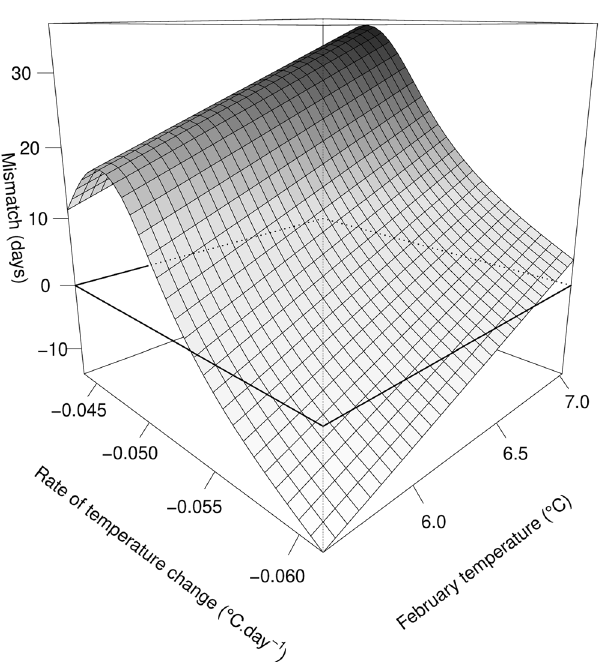
Figure 4. Relationship between the mismatch measure, the rate of temperature decrease (September- February) and average February temperatures. Perfect synchrony between predator and prey is indicated by the intersecting plan corresponding to a 0